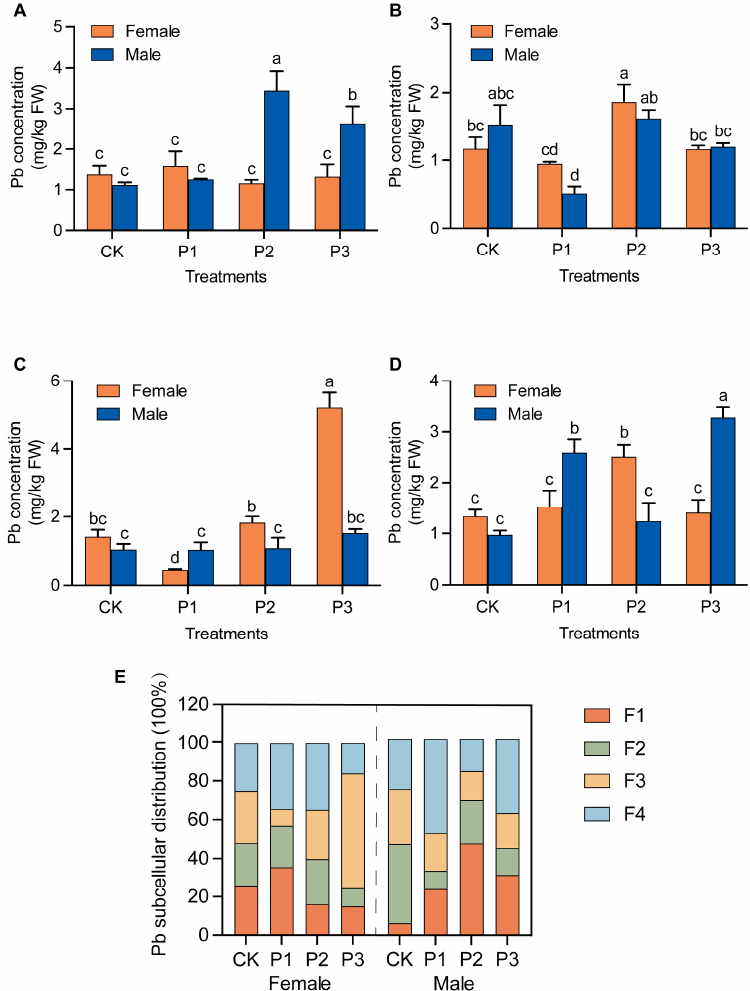
Figure 5. Pb subcellular distribution in L. cubeba female and male leaves under control and Pb treatments. The concentration of Pb in cell walls ( A ), chloroplasts and cell nuclei ( B ), mitochondria ( C ), ribosomes ( D ), and the proportion of Pb subcellular distribution in leaves ( E ). CK, P1, P2, and P3 represent 0, 1, 2, and 3 mmol Pb/kg dry soil, respectively. Values are the mean of three replicates ± SE. Values followed by the different lowercase letters significantly differed, according to Duncan’s test ( p < 0.05).